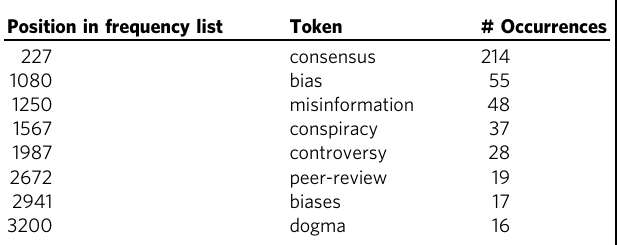
Table 2 Key lexical items for the study of intersubjective engagement in CSBC.